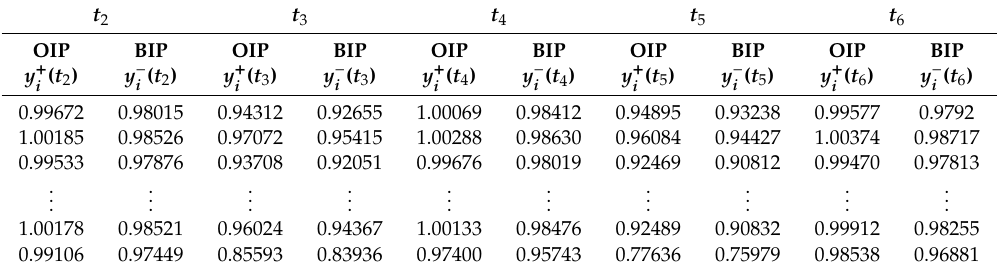
Table 9. Value of the optimal and negative incentive points (unit: